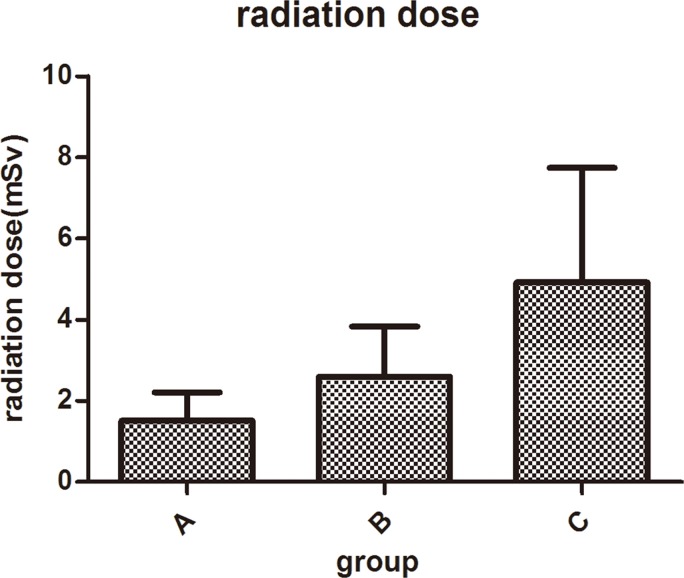
Patients’ radiation dose data.Patients’ radiation dose data of three groups(P<0.0001). It shows that radiation dose of group A is the least and group C is the most.